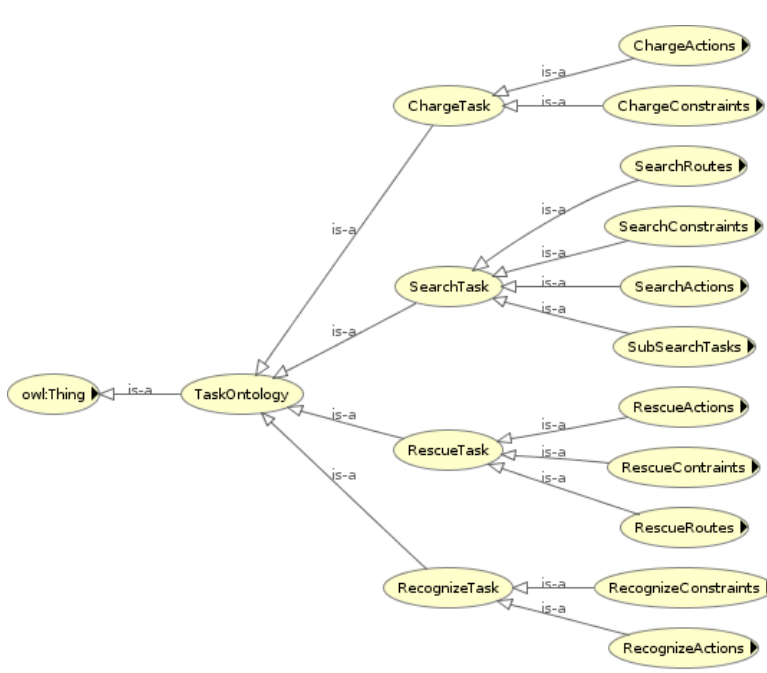
Figure 3. The task ontology is shown in Protégé.